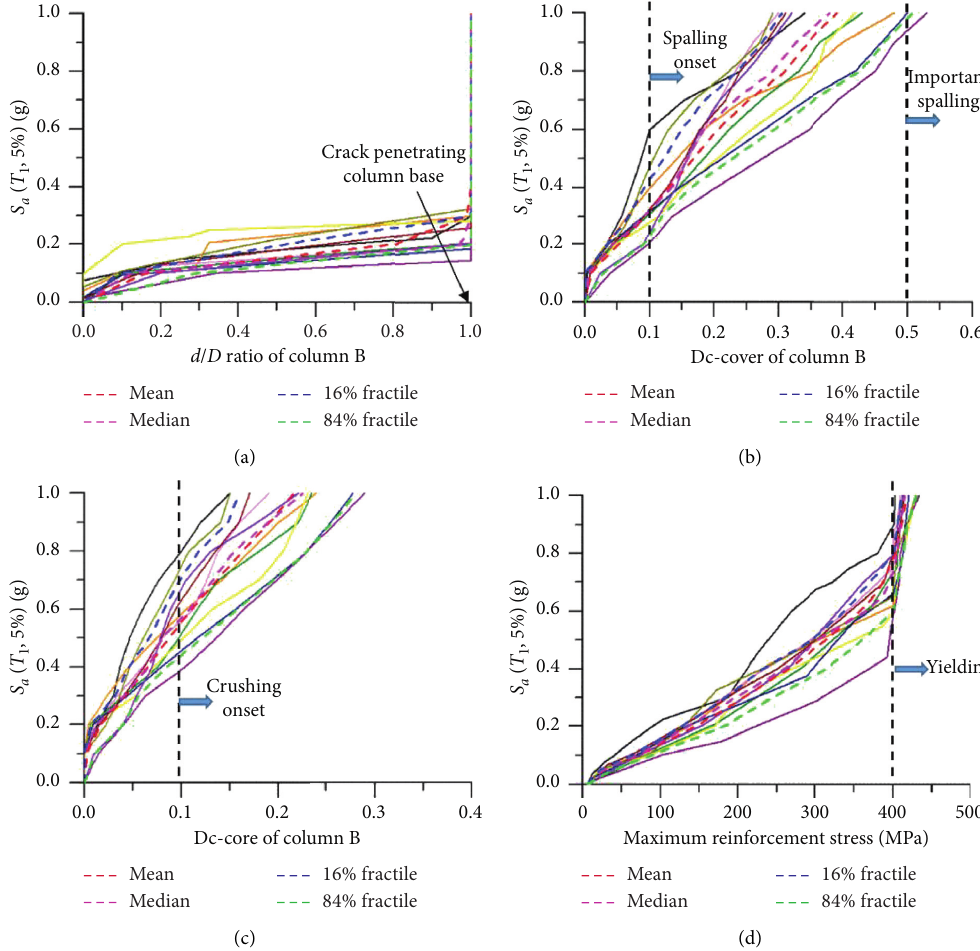
Figure 12: IDA curves of EDPs. (a) d / h . (b) D